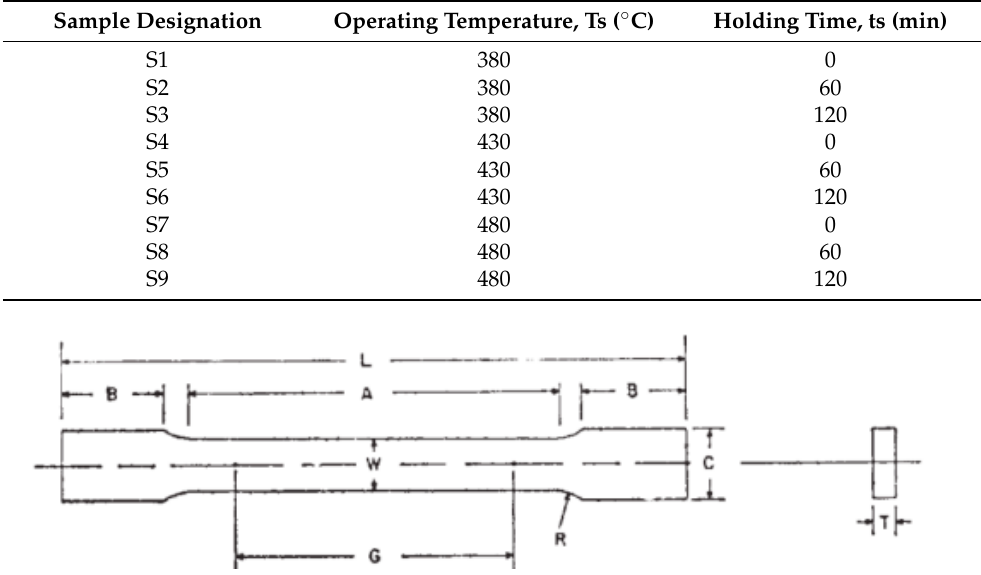
Figure 3. The dimension of recycled specimens for the tensile test (ASTM E8/E8M-16a). Table 3. The standard size specifications for dog-bone recycled